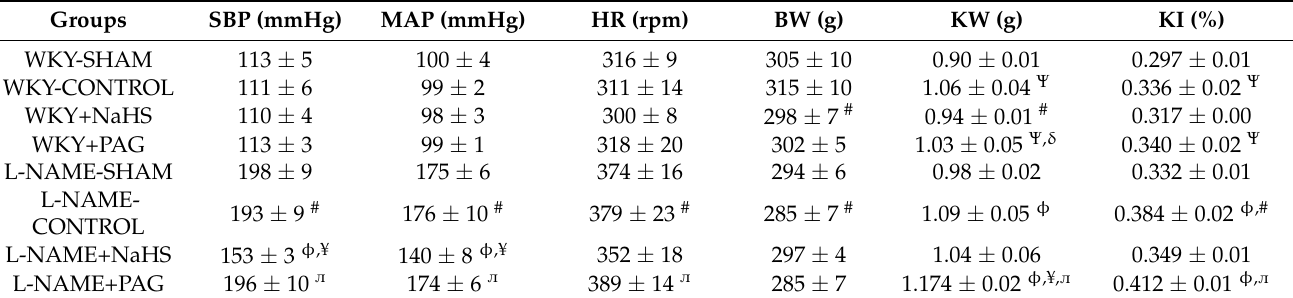
Table 2. Hemodynamics, kidney weight and kidney index for all experimental groups of WKY and L-NAME rats on acute experiment day (day